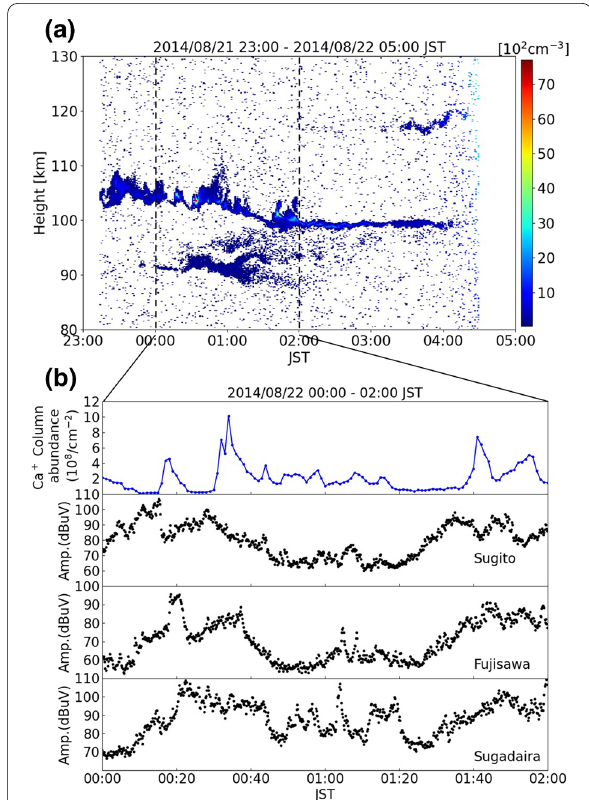
Fig. 1 Comparison between the data of the Lidar observation and HFD. a Ca + density enhancement associated with Es layer on August 21–22, 2014 plotted as a function of time and height. The Ca + density was observed by the scattering Lidar at National Institute of Polar Research (NIPR) in Tachikawa, Tokyo, Japan (Ejiri et al. 2019). b Comparison between the Ca + column abundance between 80 and 130 km (blue line) with the HFD amplitude data (black dots) on August 22, 2014. From the top to bottom, Ca + column abundance, the amplitude data from Sugito, Fujisawa, and Sugadaira are displayed as time